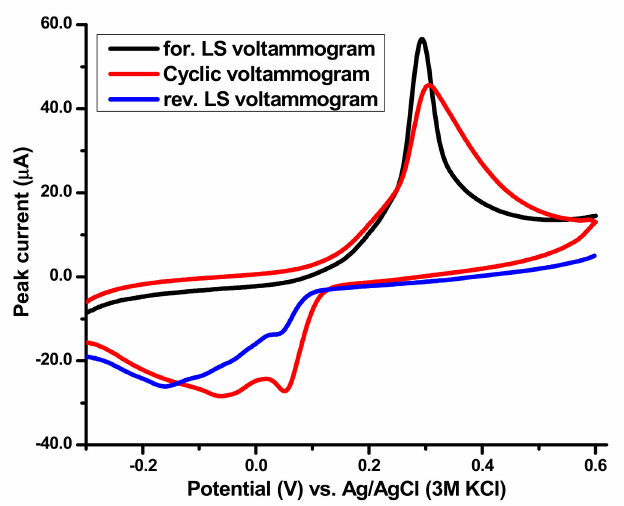
Figure 13. Linear-sweep voltammograms (LSV) vs. cyclic voltammogram (CV) for oxidation of ammonia in 0.1 M KOH at 100 mV · s − 1 on the surface of optimum